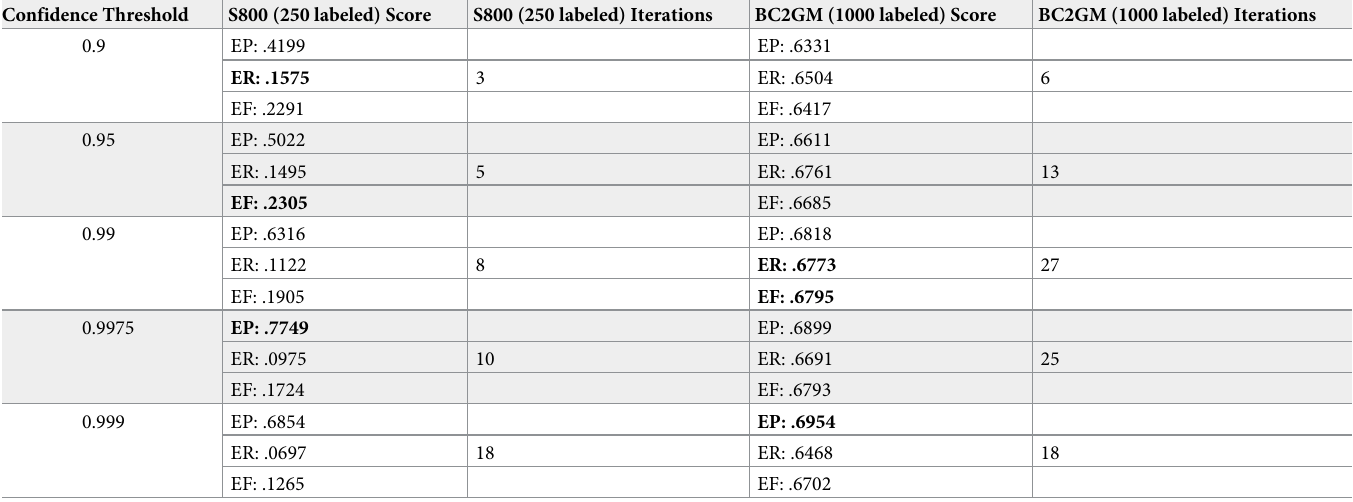
Table 10. We evaluate the BiLSTM-CRF pre-trained on SemMed1M on S800 with 250 labeled sentences and BC2GM with 1000 labeled sentences using different confidence thresholds for self-training. We report exact precision, recall, and F1 score as well as the number of self-training iterations run before no more samples from the unlabeled set meet the confidence